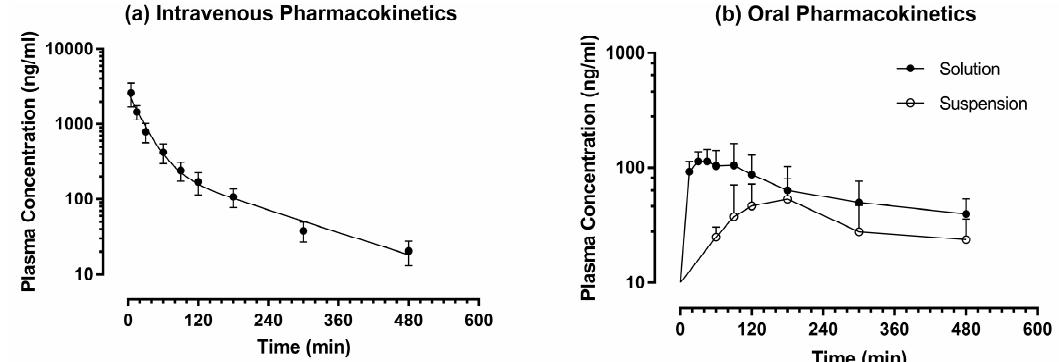
Figure 3. Pharmacokinetics of tangeretin. Symbols represent mean values while error bars represent SD. Intravenous: n = 5 except at 5 min, where n = 4; Oral solution (50 mg/kg): n = 5 except at 480 min where n = 3; Oral suspension (50 mg/kg): n = 6 except at 60 and 480 min where n = 3, at 90 and 120 min, where n = 5. Table 3. Pharmacokinetic parameters of tangeretin (TAN) a .